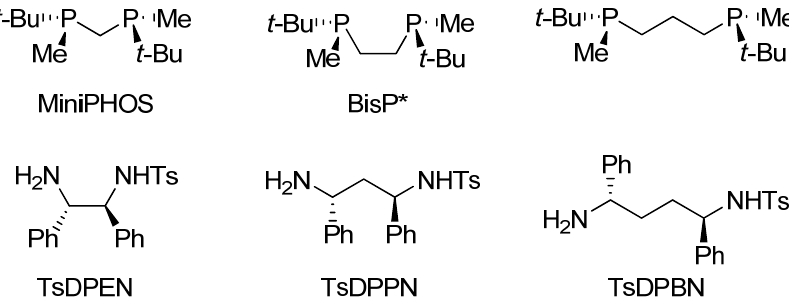
Figure 3. P,P and N,N ligands with spacers of different